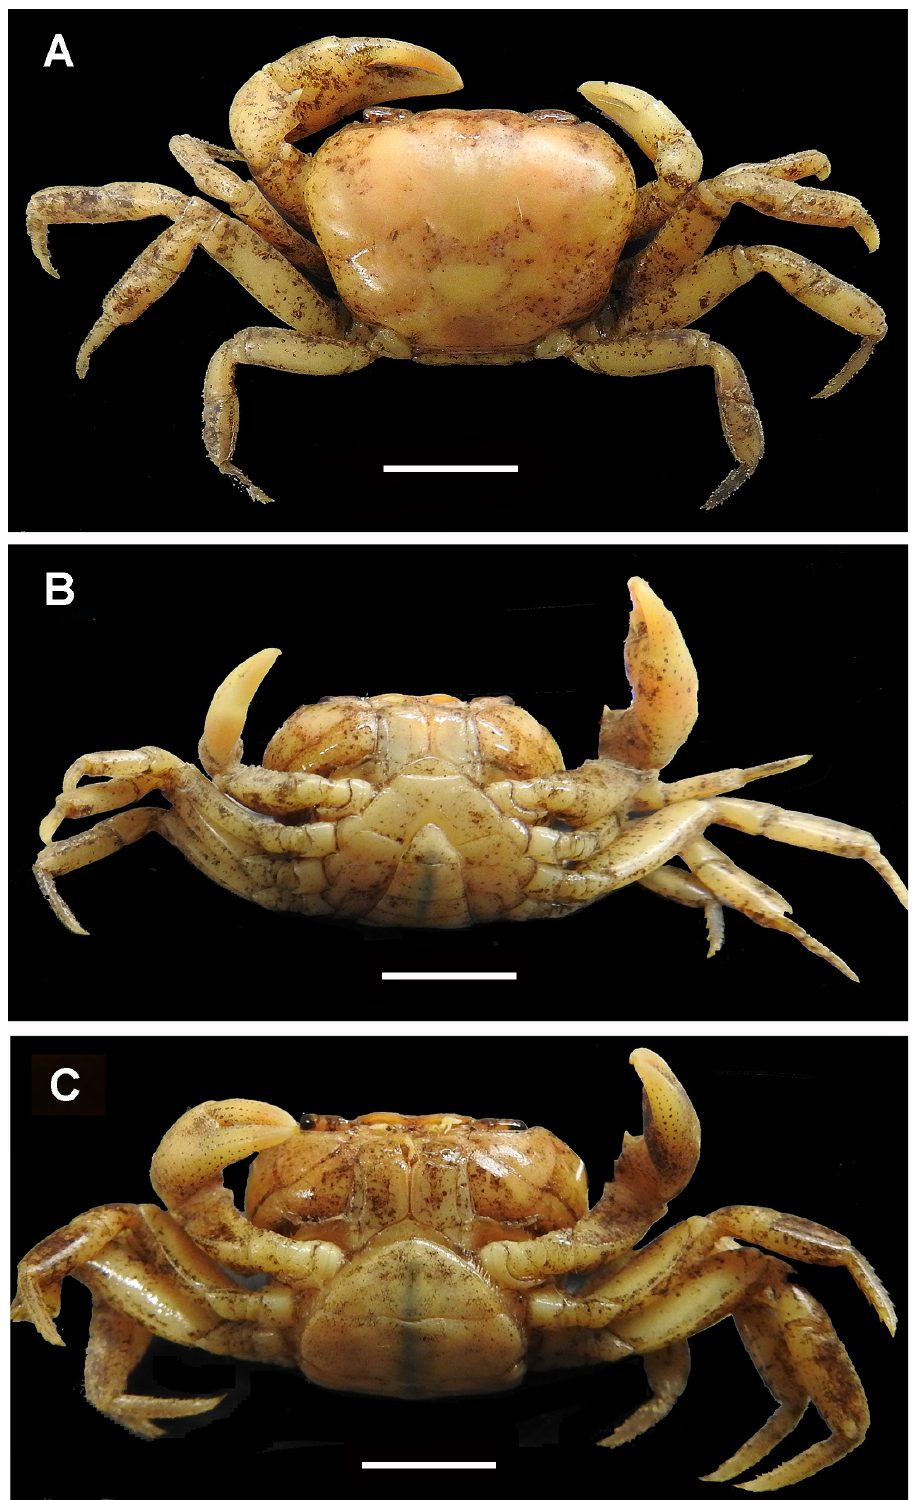
Fig. 3. Potamonautes kantsyore sp. nov. from Kantsyore Island in the Kagera River, southern Uganda. A–B . Holotype, adult ♂, CW 16.8 mm, (NHMUK 2017.29). A . Whole animal, dorsal view. B . Whole animal, ventral view. C . Paratype, adult ♀, CW 16.1 mm, (NHMUK 2017.33), whole animal, ventral view . Scale bars: A–B = 6.1 mm; C = 6.4